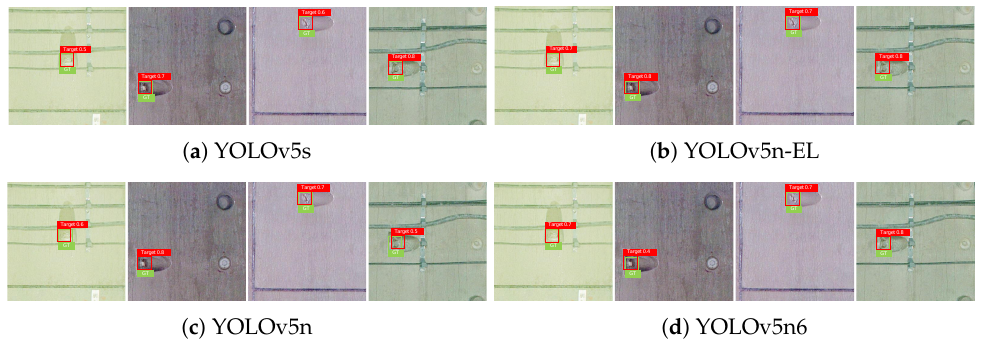
Figure 10. Examples of detection results with MSR color enhancement.